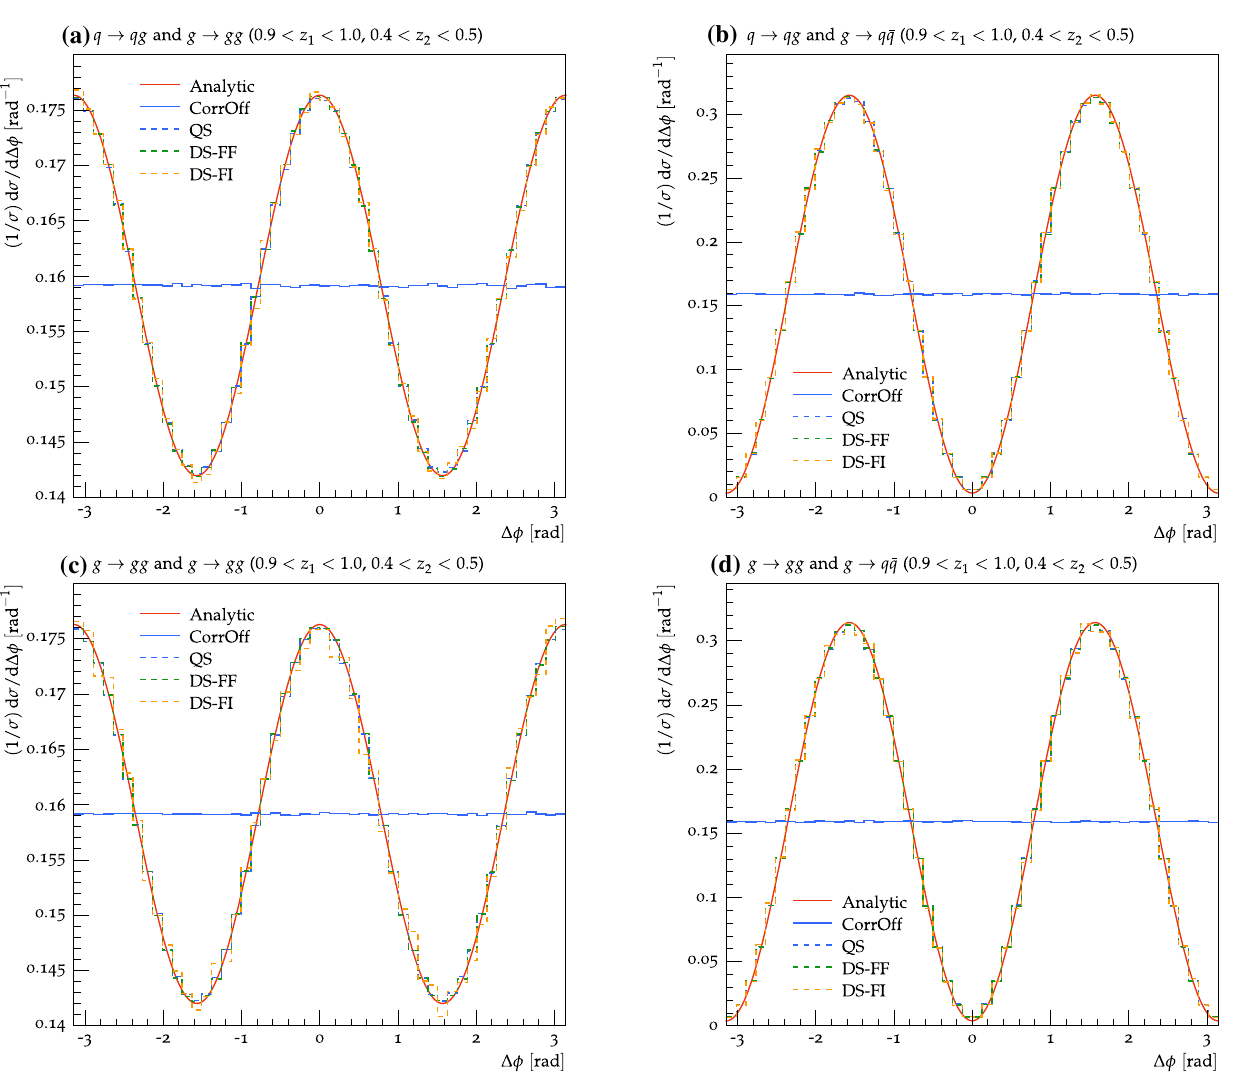
dictionsobtainedusingonlyfinal-final(DS-FF)andfinal-initial(DS-FI) dipoles in the dipole shower are shown separately. The prediction of the angular-ordered (CorrOff) shower without spin correlations is included for comparison. The momentum fractions in the first ( z 1 ) and second branchings ( z 2 ) lie in the ranges